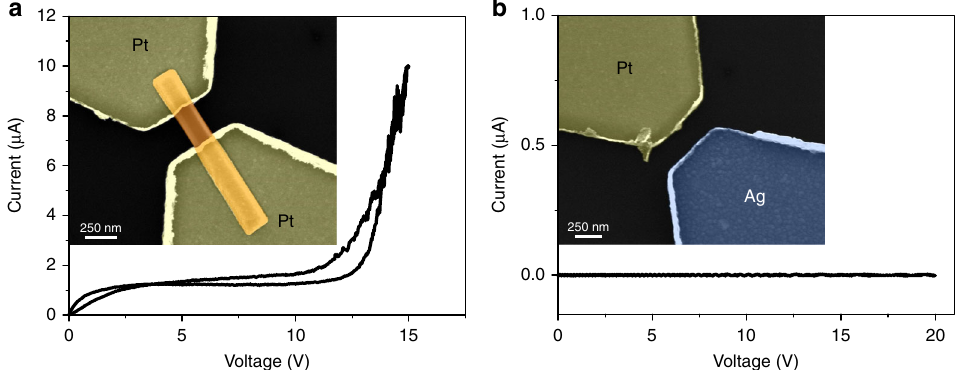
Fig. 2 Effect of electrode metal and substrate during electroforming. a Typical I – V curve of a Pt/ZnO NW/Pt device that cannot be formed even for high applied voltages. At higher applied voltages, the current breakdown of the reversely polarized metal – semiconductor junction is observed. The inset shows an SEM image (in false colours) of the Pt/ZnO NW/Pt device. b I – V curve of the control device with Pt and Ag asymmetric electrodes without the presence of the NW that cannot be formed even for high applied voltages. During measurements, the Ag electrode was biased while the Pt electrode was grounded. The resistance of the SiO 2 substrate was extrapolated to be >10 11 Ω . The inset shows an SEM image (in false colours) of the device